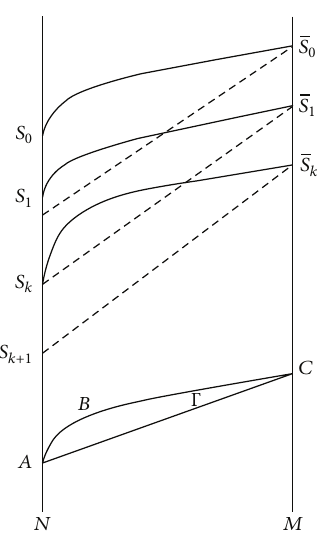
Figure 6: The existence of order-1 periodic solution of system (1) in the trapezoid 𝑂𝐴𝐺𝐹 .